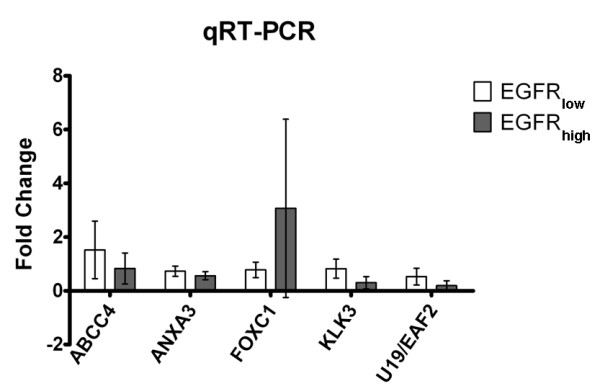
Differentially expressed genes identified by microarray analysis were validated by relative qRT-PCR. White bars represent the average mRNA levels of each gene in EGFRlow class; gray bars represent the average mRNA levels of each gene in EGFRhigh class. Fold-change was calculated as described in "methods" section.